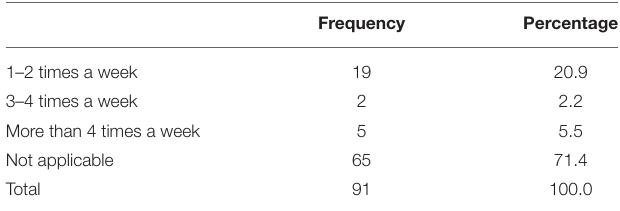
TABLE 8 | A communication tools used by staff for live conferences in synchronous mode.